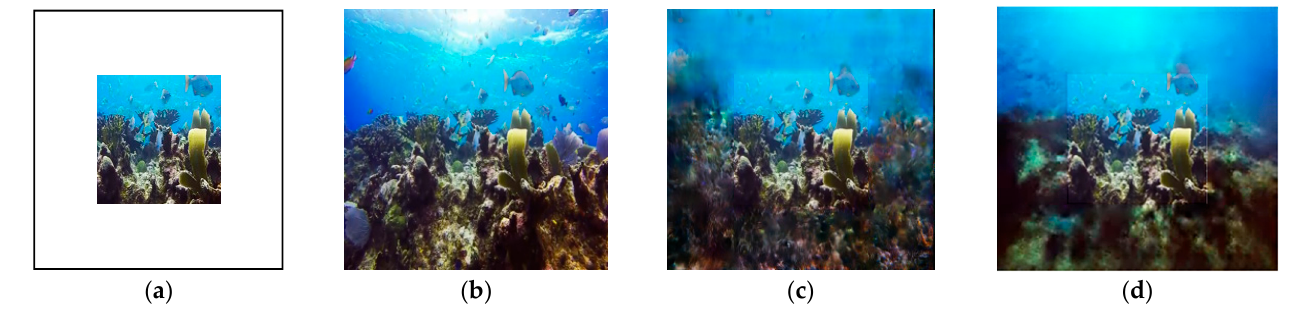
Figure 9. The comparison of the trained PCE and pix2pix architectures on the Ocean data video during testing ( a ) The input image, ( b ) The ground truth image, ( c ) The output image or frame generated by PCE network, and ( d ) The output image or frame generated by pix2pix network.